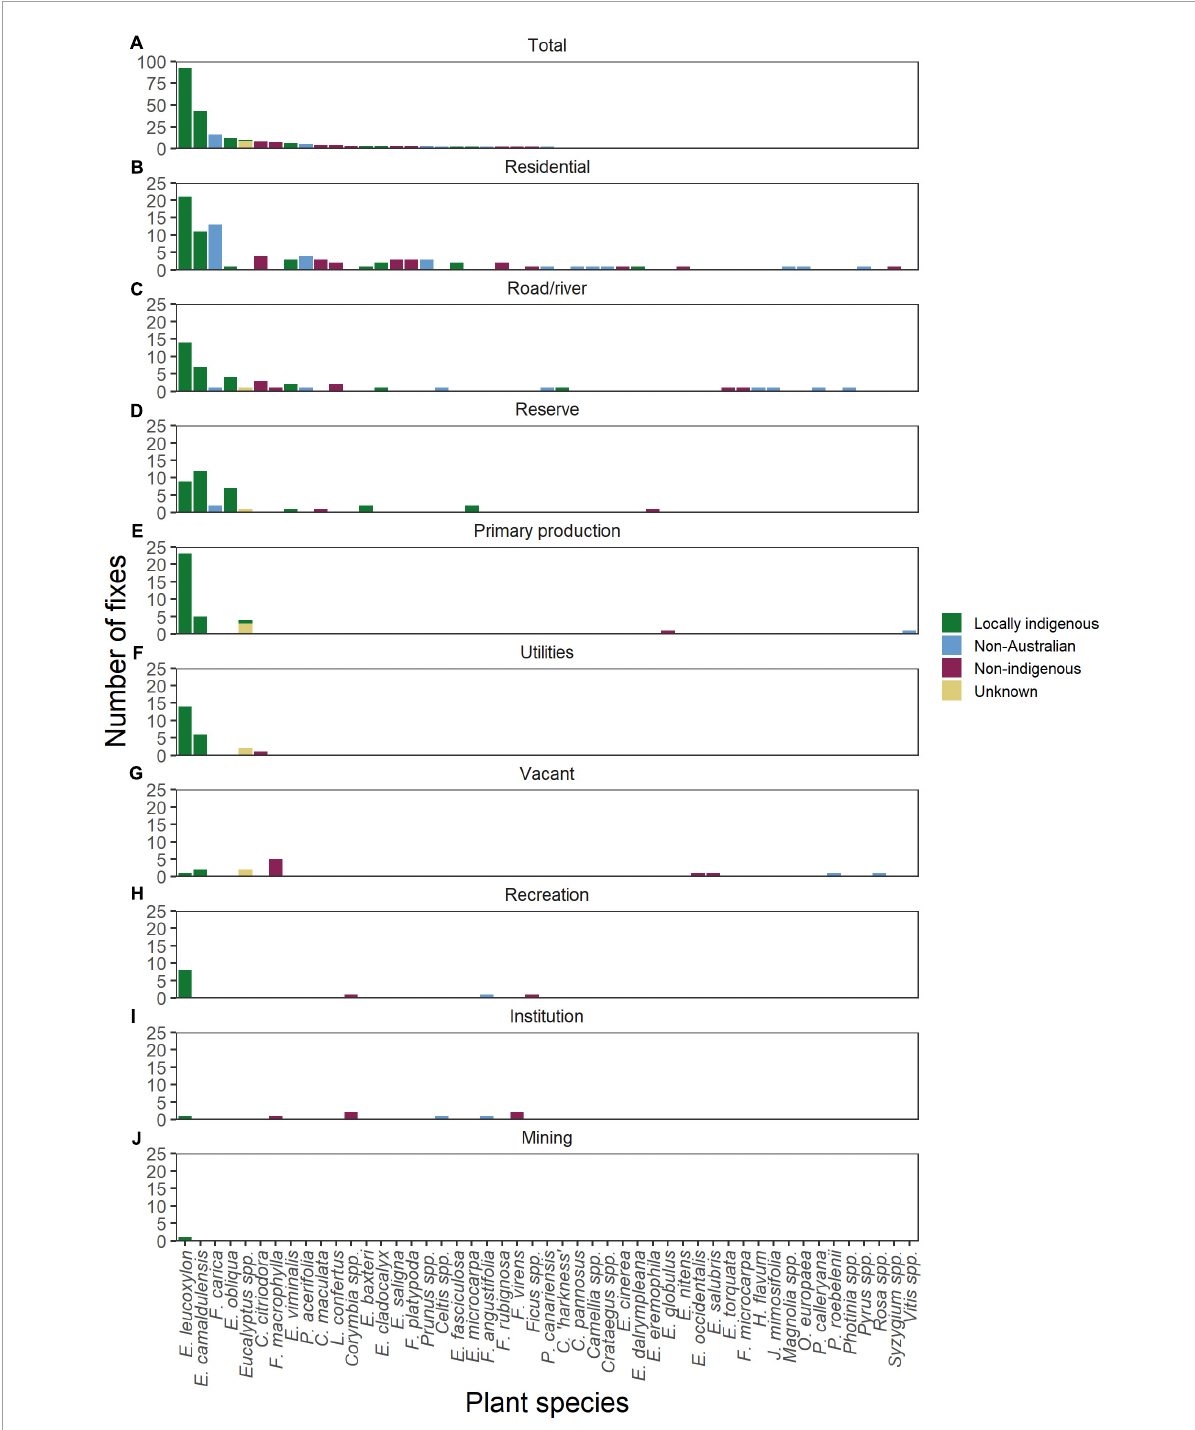
FIGURE4 The number of plant species visitations ( n = 265) by Pteropus poliocephalus. The top panel (A) shows the total number of plant species visitation across all land-use categories. The following panels show the number of visits in each land-use category separately: (B) residential ( n = 90), (C) road/river ( n = 46), (D) reserve ( n = 38), (E) primary production ( n = 34), (F) utilities ( n = 23), (G) vacant ( n = 14), (H) recreation ( n = 11), (I) institution ( n = 8), (J) mining ( n = 1). Plant species are listed in order of most feeding visitations overall. Locally indigenous plant species are shown in green, non-indigenous Australian native species are shown in maroon, non-Australian species are shown in blue, and those with unknown geographic origin are shown in yellow. Data were obtained from nine GPS tracked P. poliocephalus roosting in